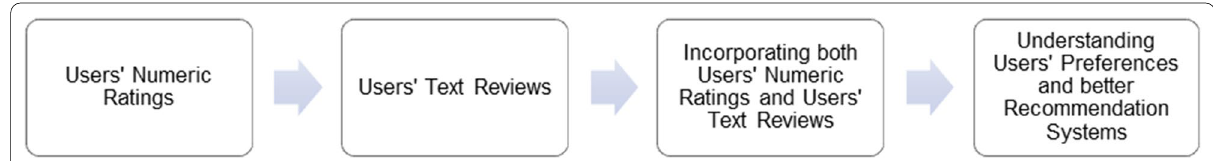
Fig. 5 The enhanced model for recommendation